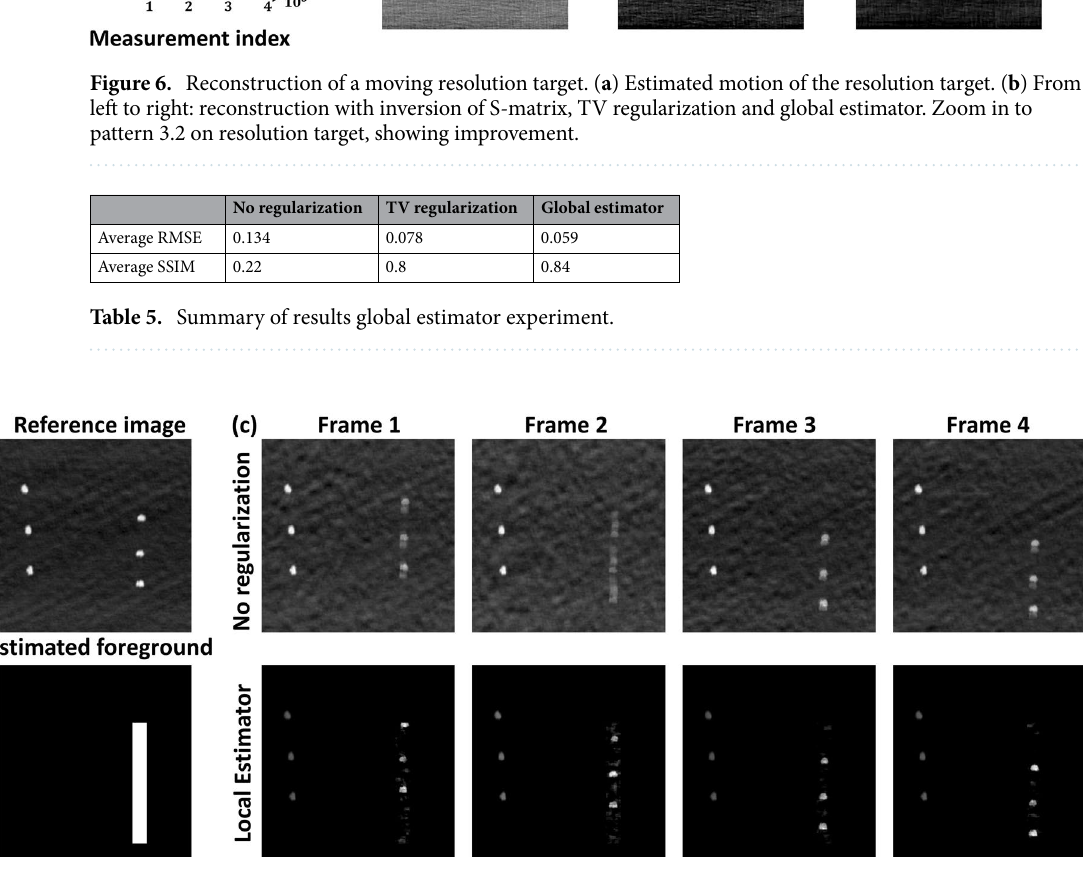
Figure 7. Reconstruction of a moving target with static background. ( a ) Is a reference image taken with stationary points. ( b ) Estimated foreground of moving parts. ( c ) First row is reconstruction using inverse s-matrix. Second row is reconstruction using local estimator